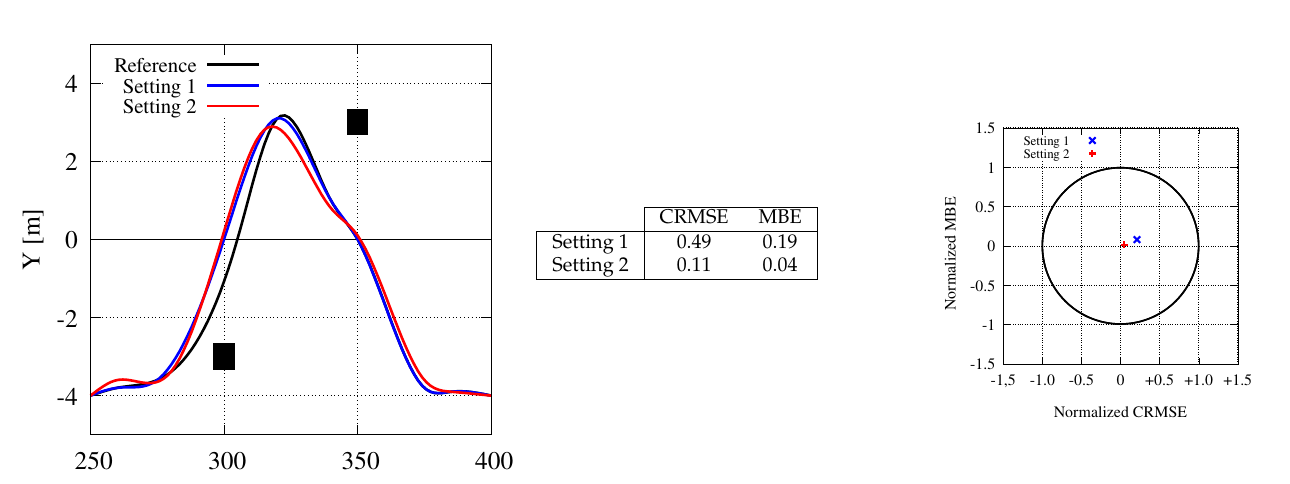
Figure 18. Generated paths for the elk (or moose) maneuver. The CPU trajectory (black color) is represented as a reference for the two GPU ones (blue and red